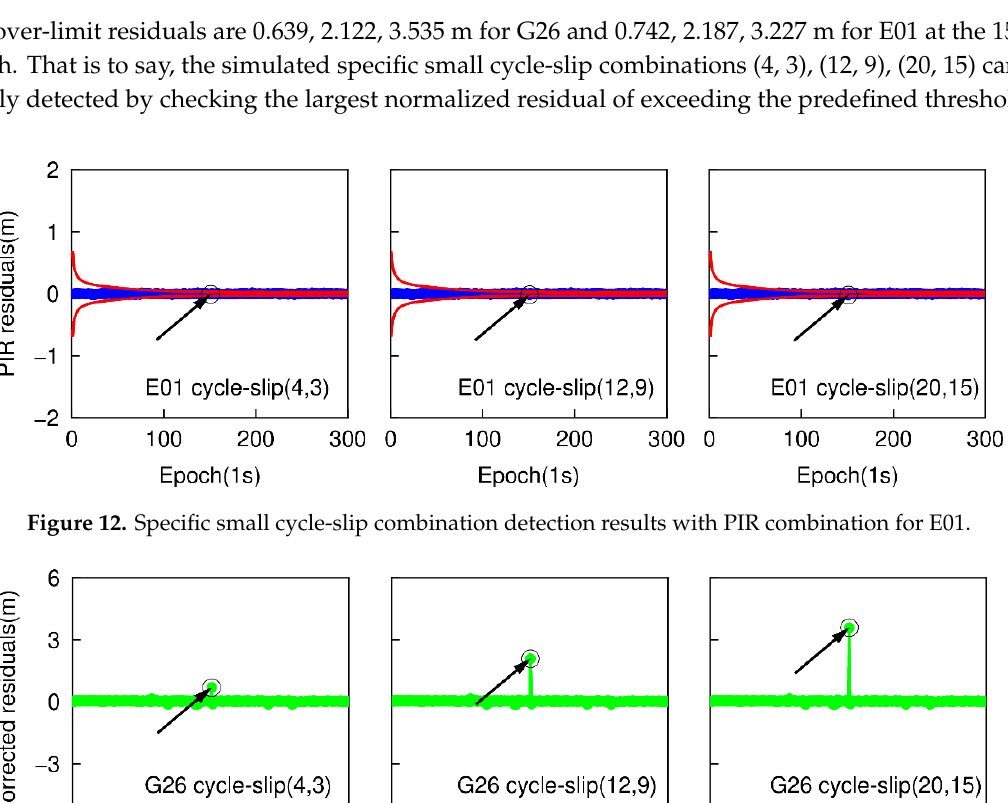
Figure 11. Specific small cycle-slip combination detection results with PIR combination for G26.